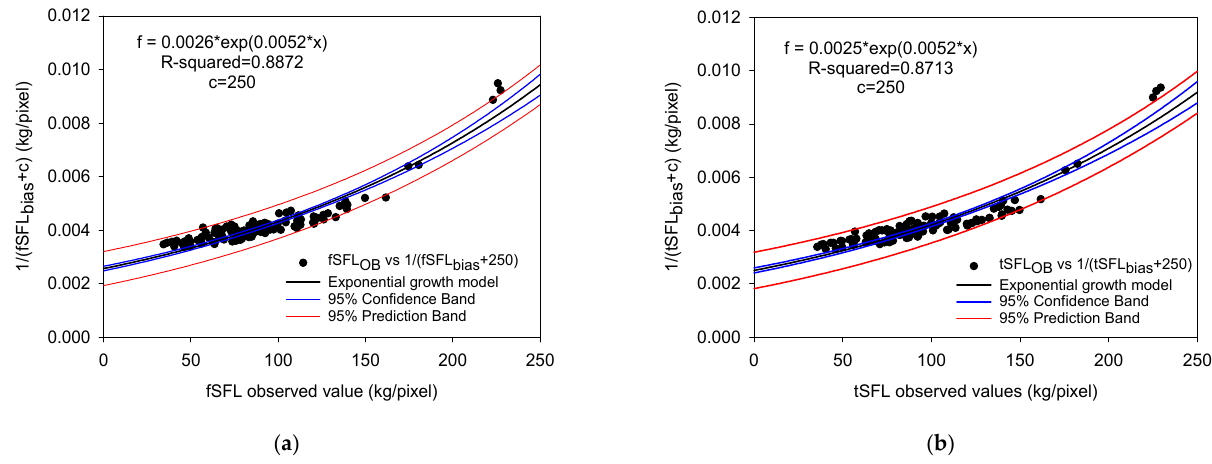
Figure 11. Nonlinear dependency of the surface fuel load estimation bias on the amount of observed surface fuel load. The transformed bias of the original lnfSFL-BioTopo model and the lntSFL-BioTopo model was positively related to the values of fSFL ( a ) and tSFL ( b ).